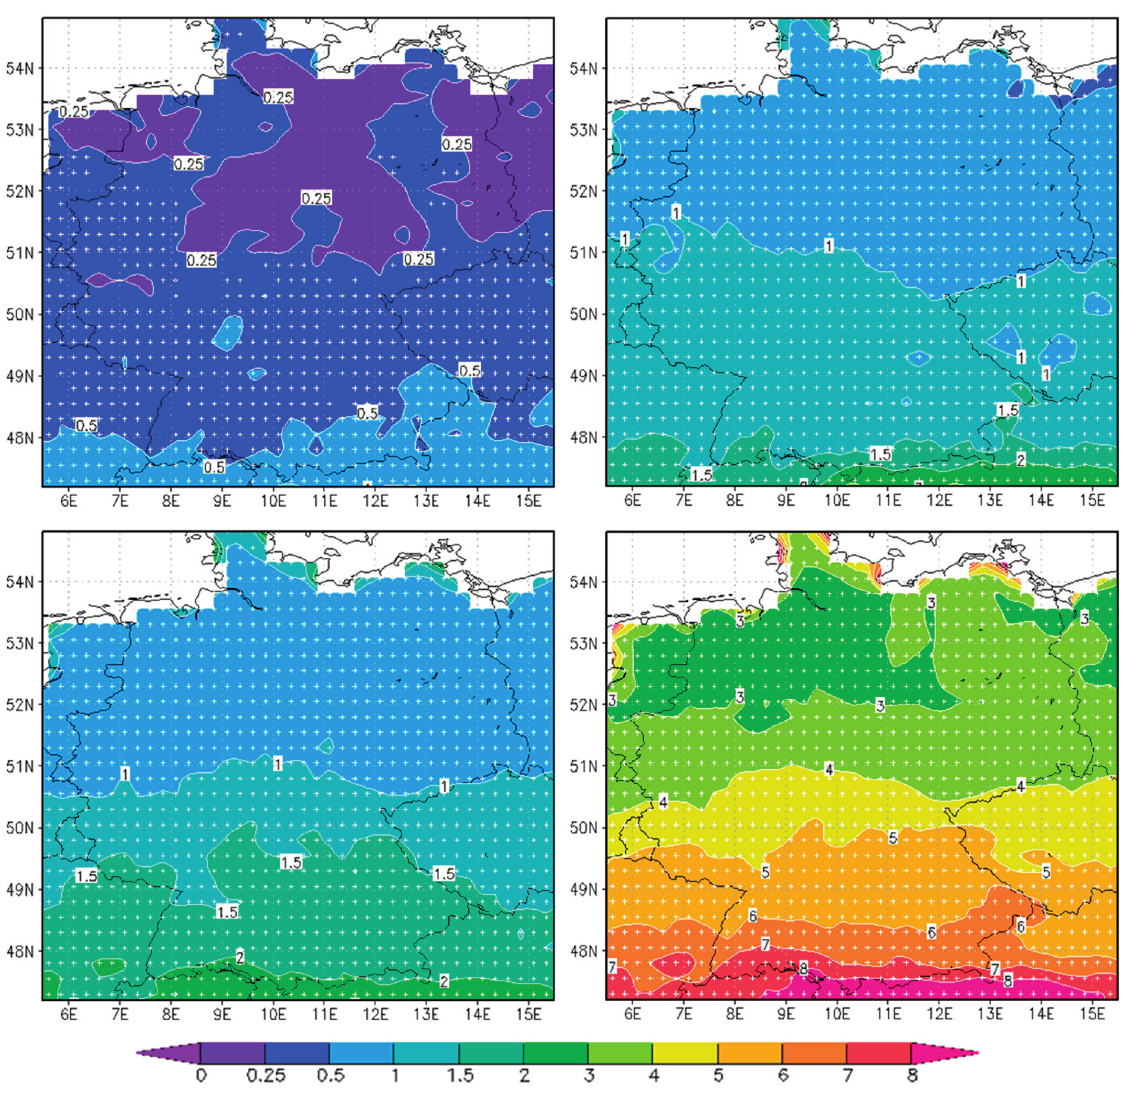
Figure 2. Projected ensemble mean changes of the average duration of heat waves ( left ) and the longest duration of heat waves per summer ( right ) for 2021–2050 ( top ) and 2069–2098 ( bottom ), expressed as difference in days with respect to the control period 1971–2000. Grid points with significant changes ( α < 0.05) between present and future climate are marked by white